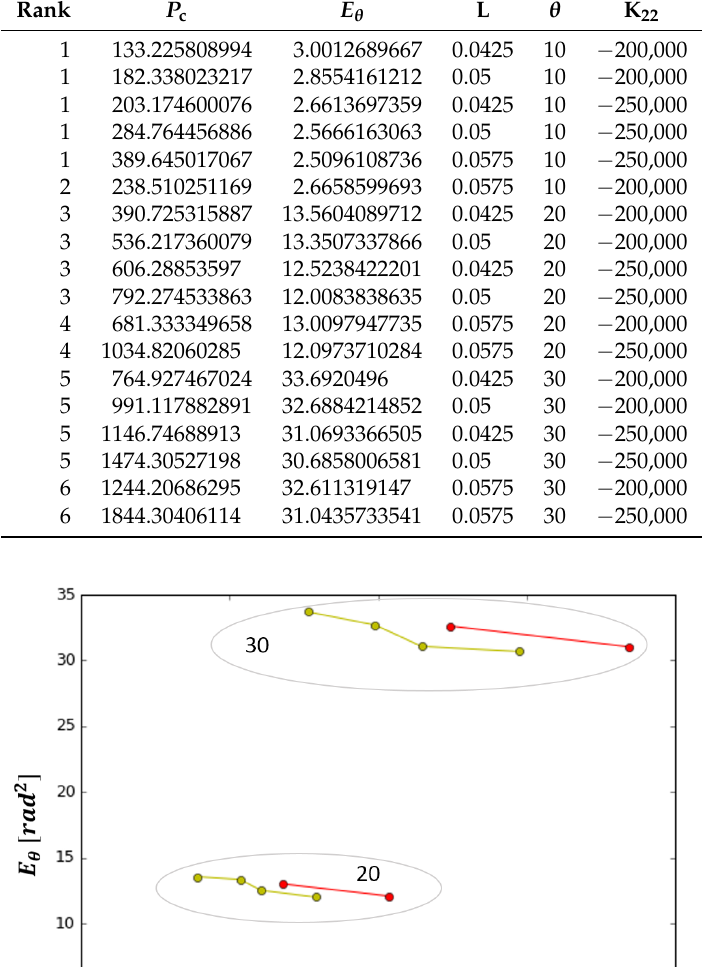
Table 5. Pareto ranking for P c and E θ .